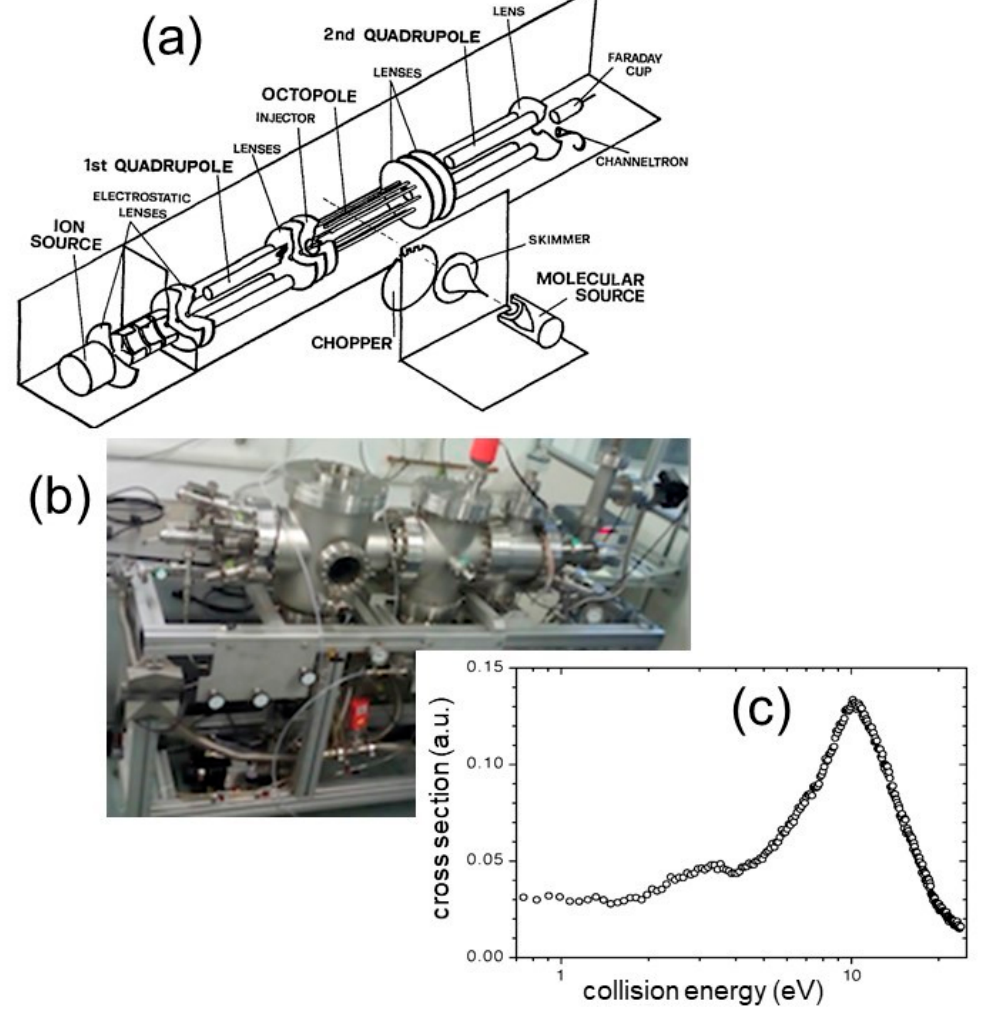
Figure 4. The ion guide molecular beam apparatus used in the Trento experiment on 1998 for the first production of molecular dications containing rare gases by ion molecule reaction: ( a ) a scheme of the experiment; ( b ) a picture of the machine; ( c ) the cross section for the studied reaction Ar 2+ + N 2 → ArN 2+ + N as a function of the collision energy [64].